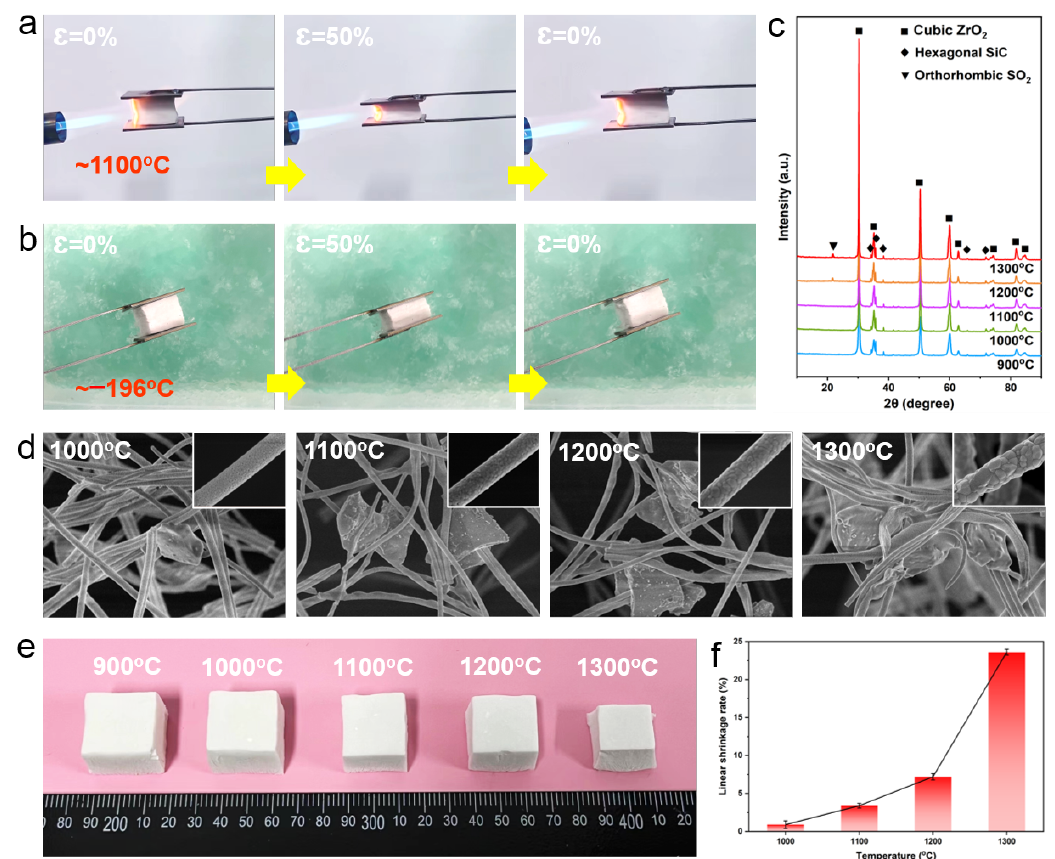
Figure 6. In situ compression experiments in ( a ) butane torch (~1100 °C) and ( b ) liquid nitrogen (~−196 °C). ( c ) XRD patterns of S50ZFA-2.0 after heat treatment at different temperatures. ( d ) SEM photographs and enlarged views of fibers (inset) of S50ZFA-2.0 after heat treatment at different temperatures. ( e ) Macroscopic photographs and ( f ) linear shrinkage rate of S50ZFA-2.0 after heat treatment at various temperatures.